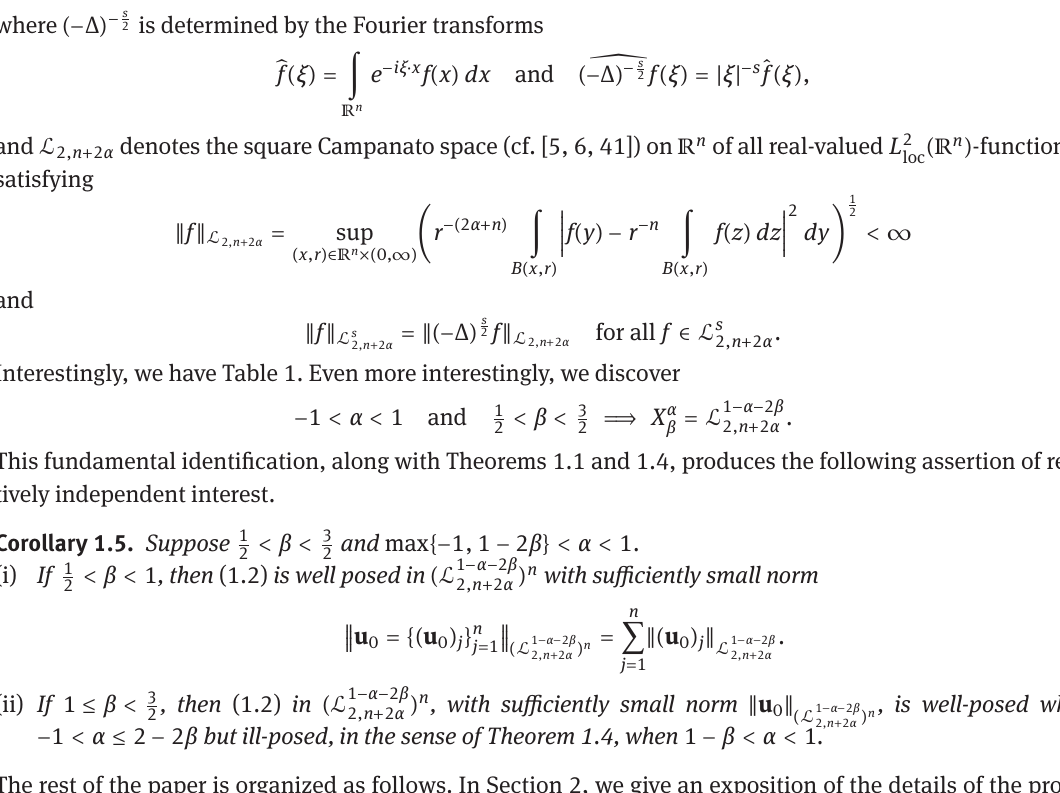
− 1 < α < 1 α ∈ (− 1, 0 ) α = 0 α ∈ ( 0, 1 ) L s 2, n + 2